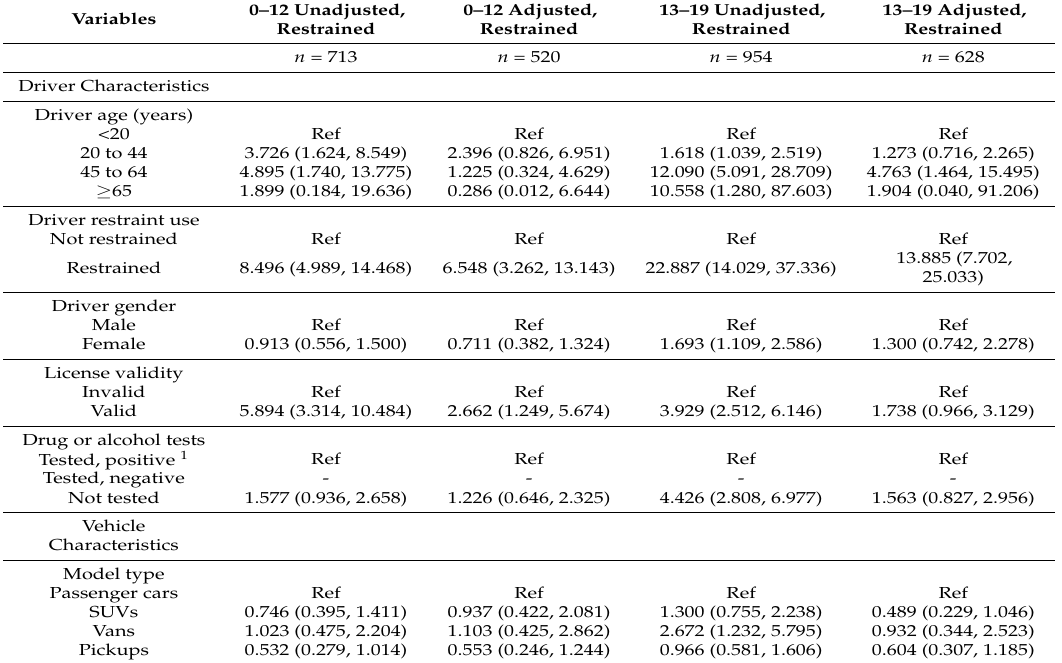
Table 3. Unadjusted and adjusted ORs (95% CIs) for infant, child and teen restraint status on Indian lands in the states with federally recognized Indian lands, FARS 2000–2014, divided by passenger ages 0–12 and 13–19 years.